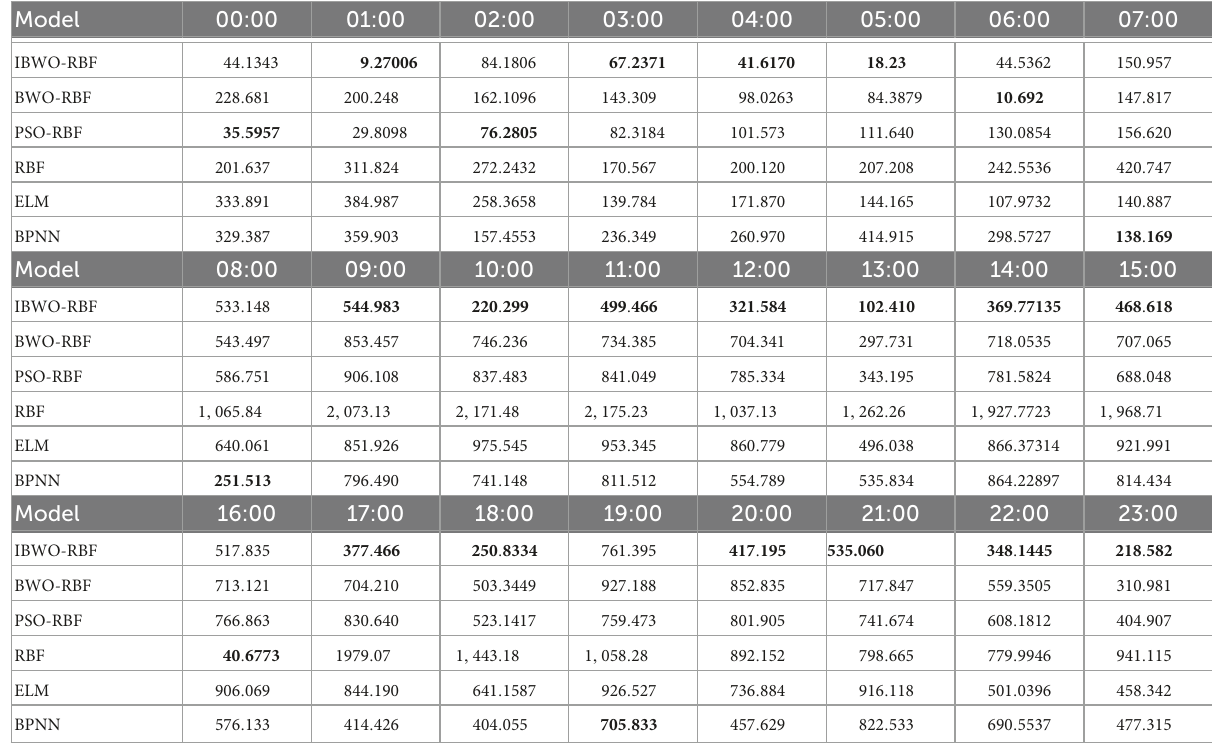
TABLE 9 Comparison of prediction errors of 6